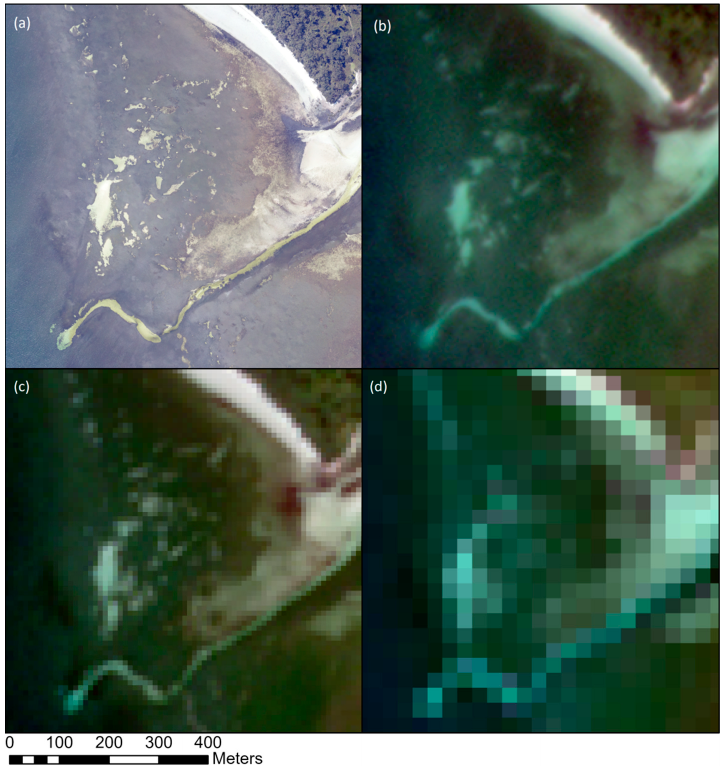
Figure 2. A patchy seagrass meadow in Jervis Bay NSW, Australia, displayed at four different spatial resolutions. This demonstrates the effect of image spatial resolution on the representation of spatial arrangement in seagrass ecosystems. Images sourced from ( a ) ArborCam aerial imagery (0.05 m spatial resolution, captured 15 October 2020), ( b ) PlanetScope (3 m spatial resolution, cap-